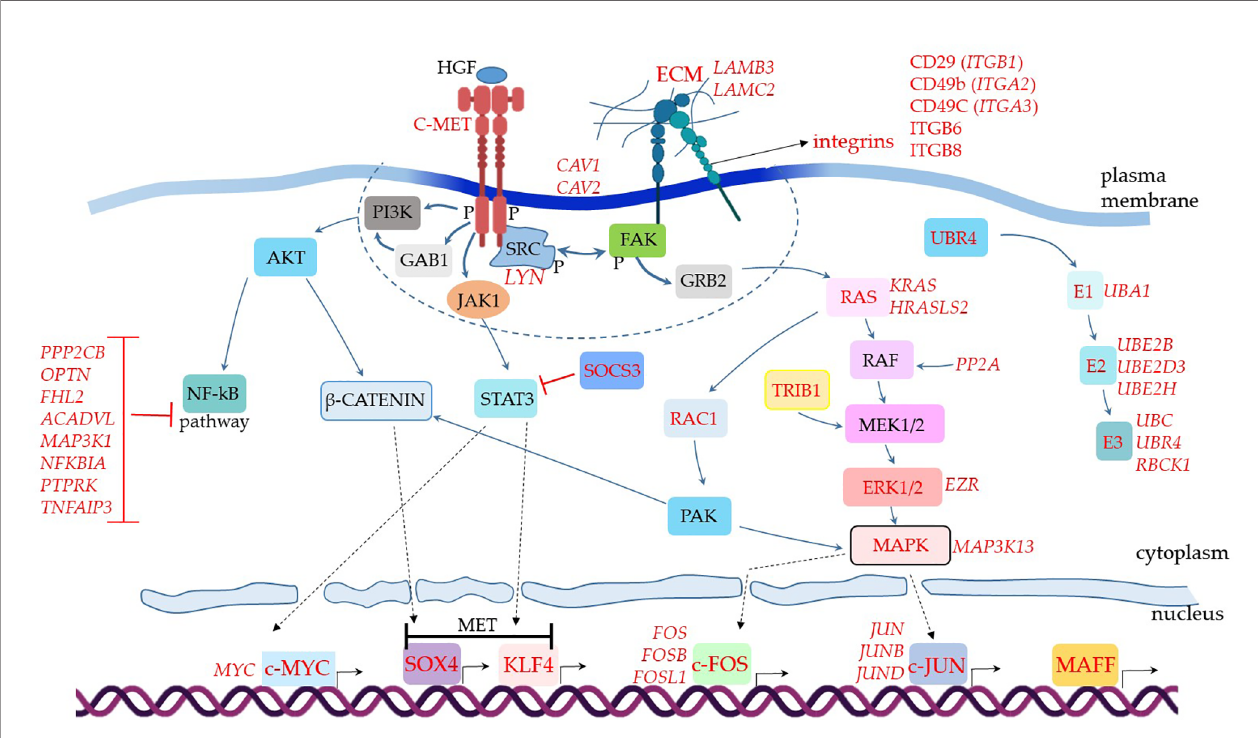
FIGURE 3 | Assumed biochemical molecular pathways triggered in MSCs. The genes were analyzed in MSCs from BAL fl uid of COVID-19 patients. This comparative analysis evaluated upregulated genes when comparing COVID-19 patients with severe over individuals with mild symptoms. The upregulated genes are assigned in red, and the genes expressed at a similar level comparing both groups are indicated in black. C-MET means mesenchymal-epithelial transition factor. The dashed line represents membrane-associated and close downstream molecules. Dashed arrows represent molecular physical translocation to the nucleus or activation of nuclear transcription